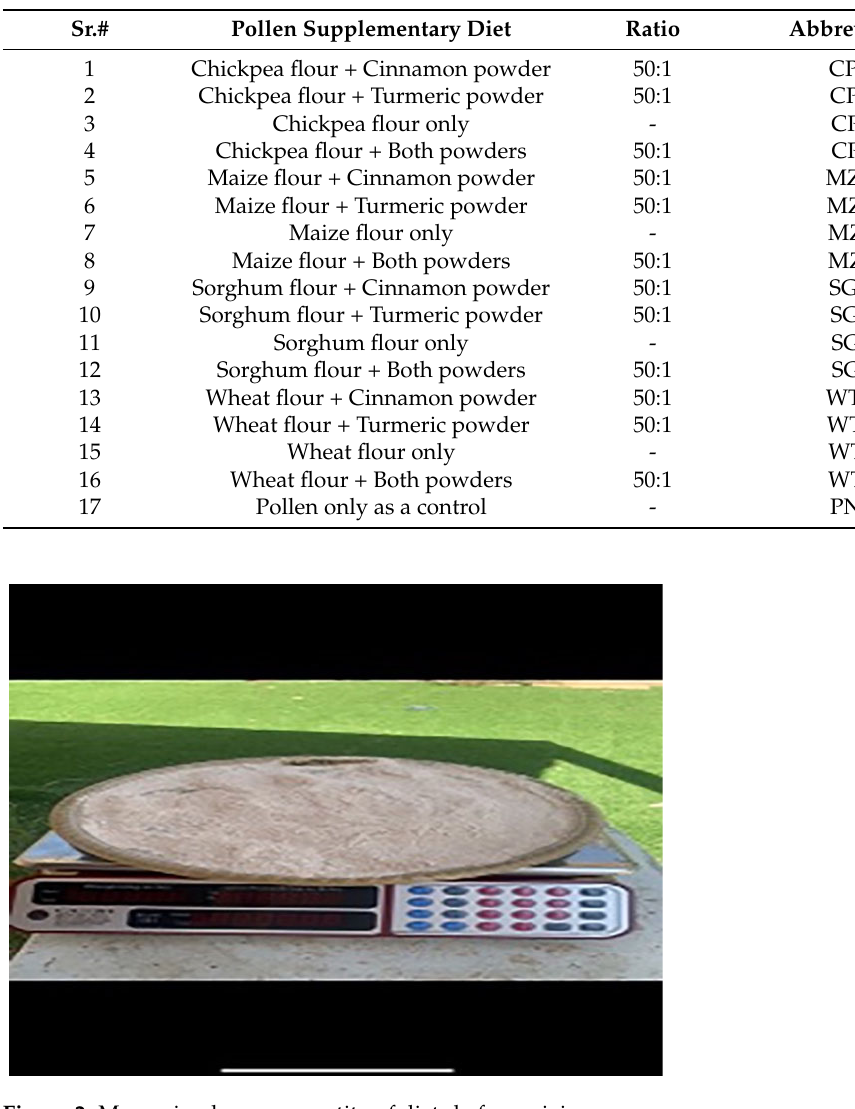
Figure 2. Measuring known quantity of diets before